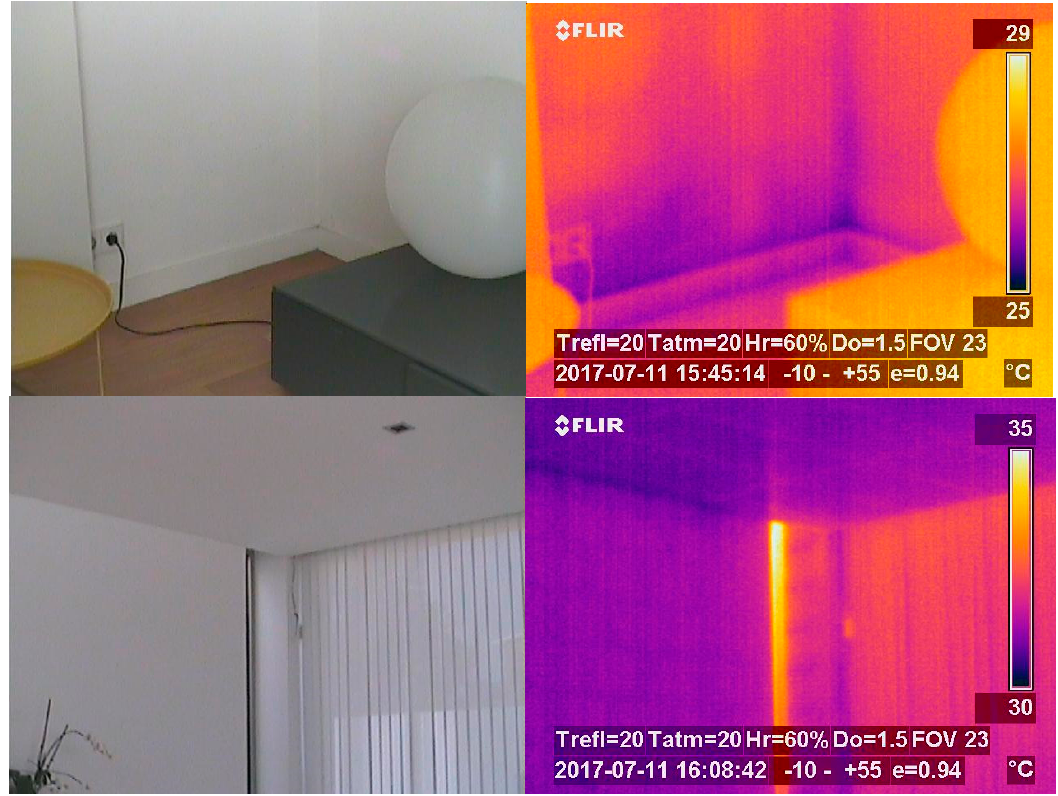
Figure 20. The thermographic images. Thermal bridges.